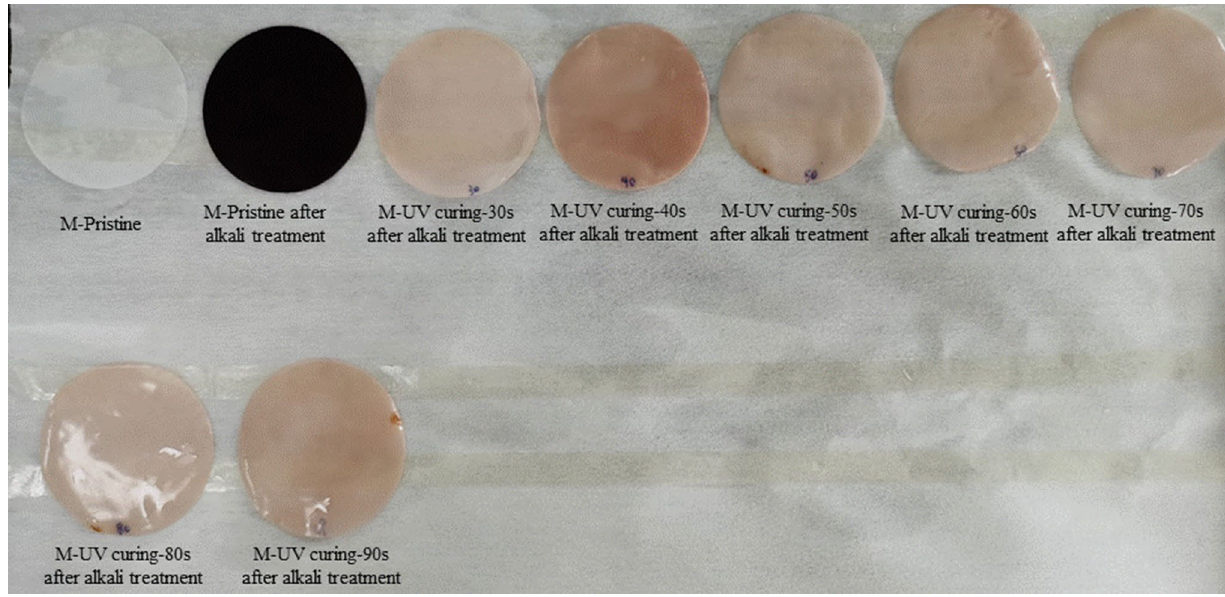
Fig. 1 Effect of NaOH treatment on